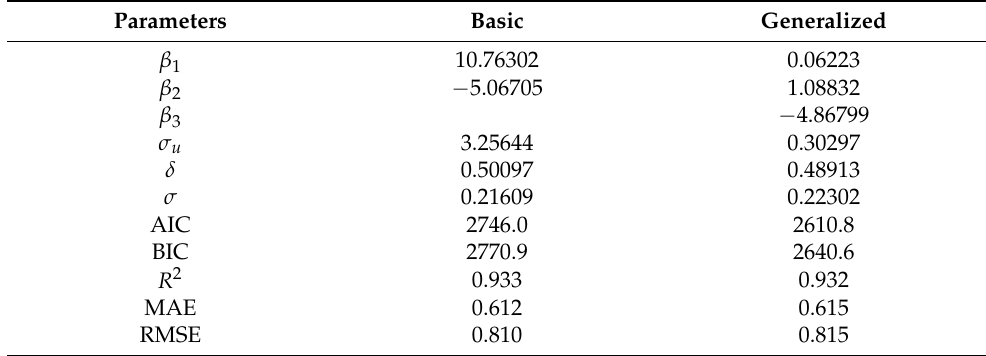
Table 4. Parameter estimations and statistical criteria of the basic and generalized mixed-effects